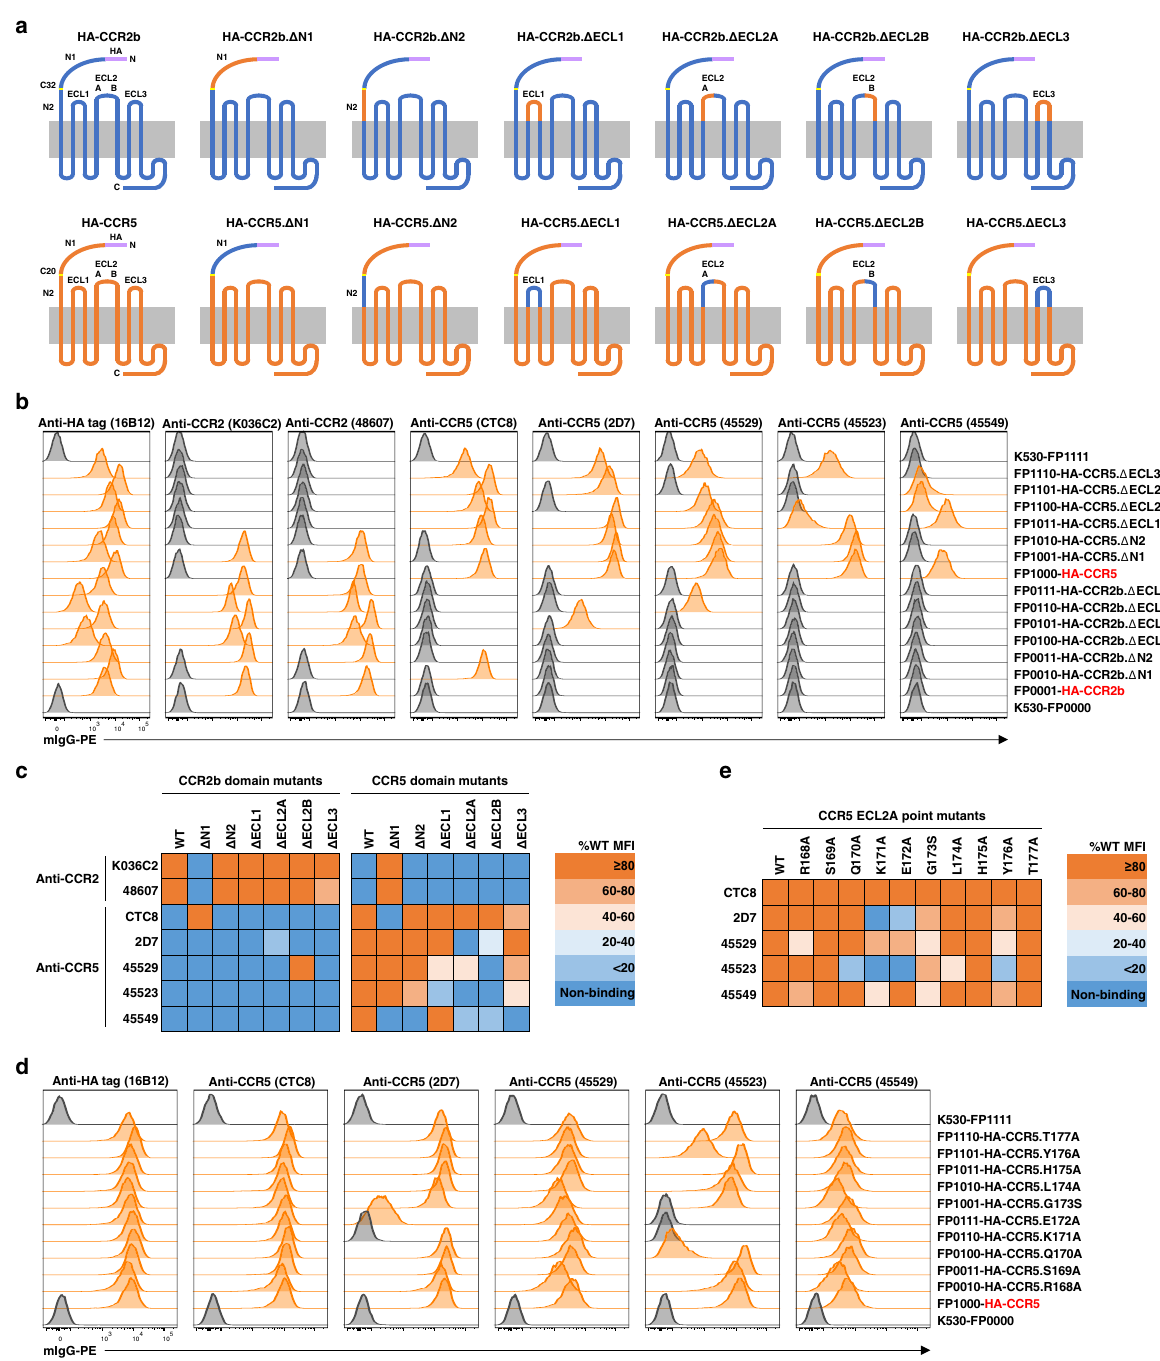
Fig. 3 Application of the multiplex immunoassay in domain/epitope mapping of antibodies speci fi c for human CCR2 and CCR5. a Schematic diagrams showing CCR2b and CCR5 domain-swapped mutants expressed on reporter cell lines. An N-terminal HA-tag was included to normalize surface expression levels of different mutants. b Domain mapping with multiplexed reporter cell lines expressing CCR2b and CCR5 domain-swapped mutants. The binding to each reporter cell line was demultiplexed as shown in Fig. 1. Histograms with MFI values above twofold of background (the average MFI value of internal control cell lines K530-FP0000 and K530-FP1111) were scored as positive and highlighted in orange. c Heat map of the relative binding activities of antibodies tested in b . Background-subtracted MFI values were fi rst normalized to that with anti-HA-tag antibody and then to corresponding cell lines expressing WT molecules. Percentages of WT MFI values were color-coded according to the key. Negative readouts in b were indicated as non-binding. d Epitope mapping with multiplexed reporter cell lines expressing CCR5 ECL2A point mutants. The data were analyzed in the same way as in b . e Heat map of the relative binding activities of antibodies tested in d and plotted in the same way as in c . All monoclonal mouse antibodies were used at 5 µ g/ml. Data from one experiment are shown. Data from another two independent repeat experiments are shown in Supplementary Fig. 11. MFI values for individual histograms are listed in Supplementary Tables 3 and